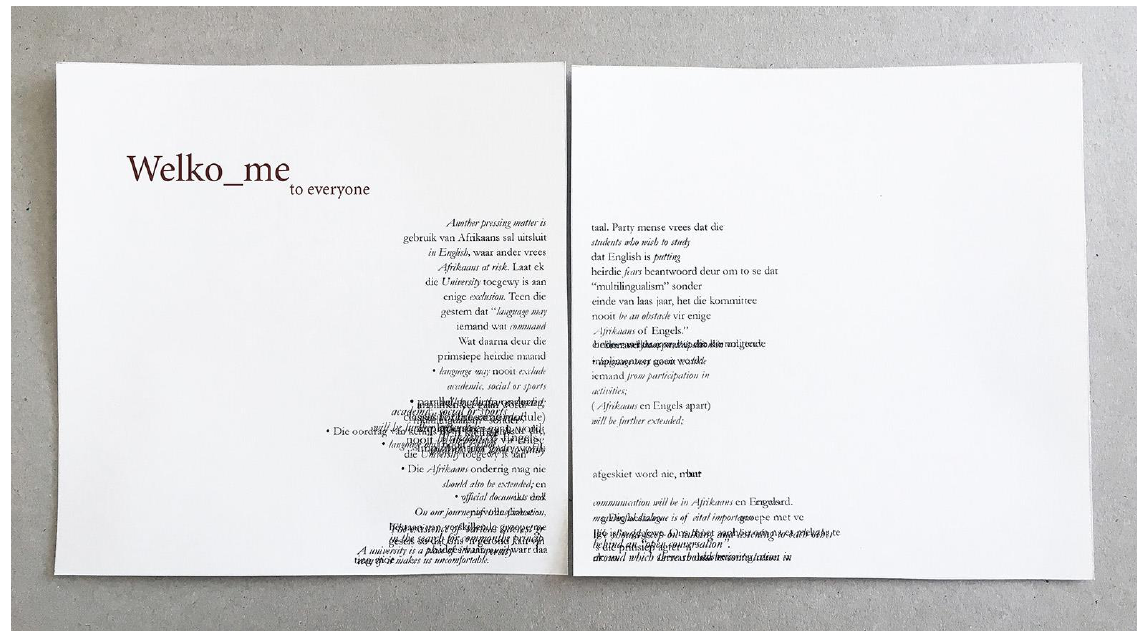
Figure 3 : Project 3: Experimental layout (Source: Mandy, 2016) In playing with typographic layout and composition, Mandy (2016) said, ‘I found a way to work with the disunity and chaos of it all. I think the disunity in all the students’ statements made the message stronger than if I had to use one person’s opinion . ’ It